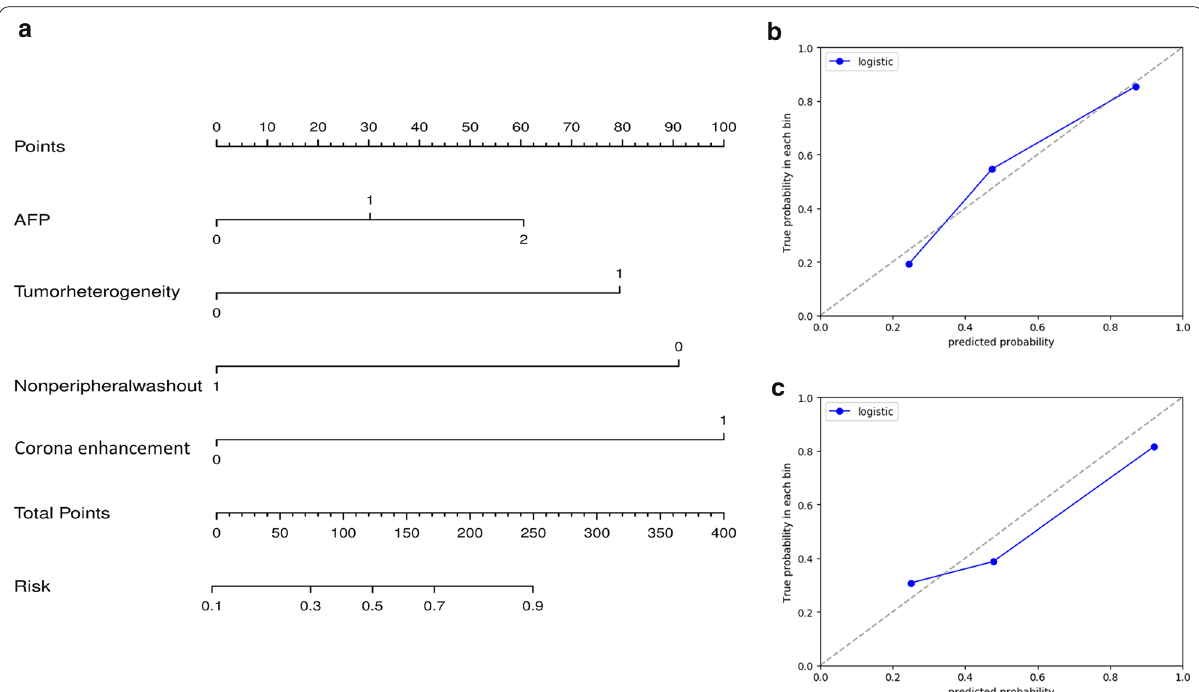
Fig. 6 Development of nomogram ( a ) and calibration curves ( b , c ) for model 1. It incorporates alpha-fetoprotein levels (AFP), tumor heterogeneity, non-peripheral washout, and corona enhancement. AFP: 0, 1, and 2 represent serum AFP levels of < 20 ng/ml, 20–400 ng/ml, and > 400 ng/ml, respectively. Tumor heterogeneity: 0 and 1 represent homogenous and heterogenous tumor appearance, respectively. 0 represents absence, and 1 represents the presence of washout and APE, respectively. The calibration curves in training ( b ) and validation ( c ) cohorts show the calibration of the nomogram. The diagonal gray dotted line represents the true MTHCC rates, while the blue line demonstrates the predictive performance of